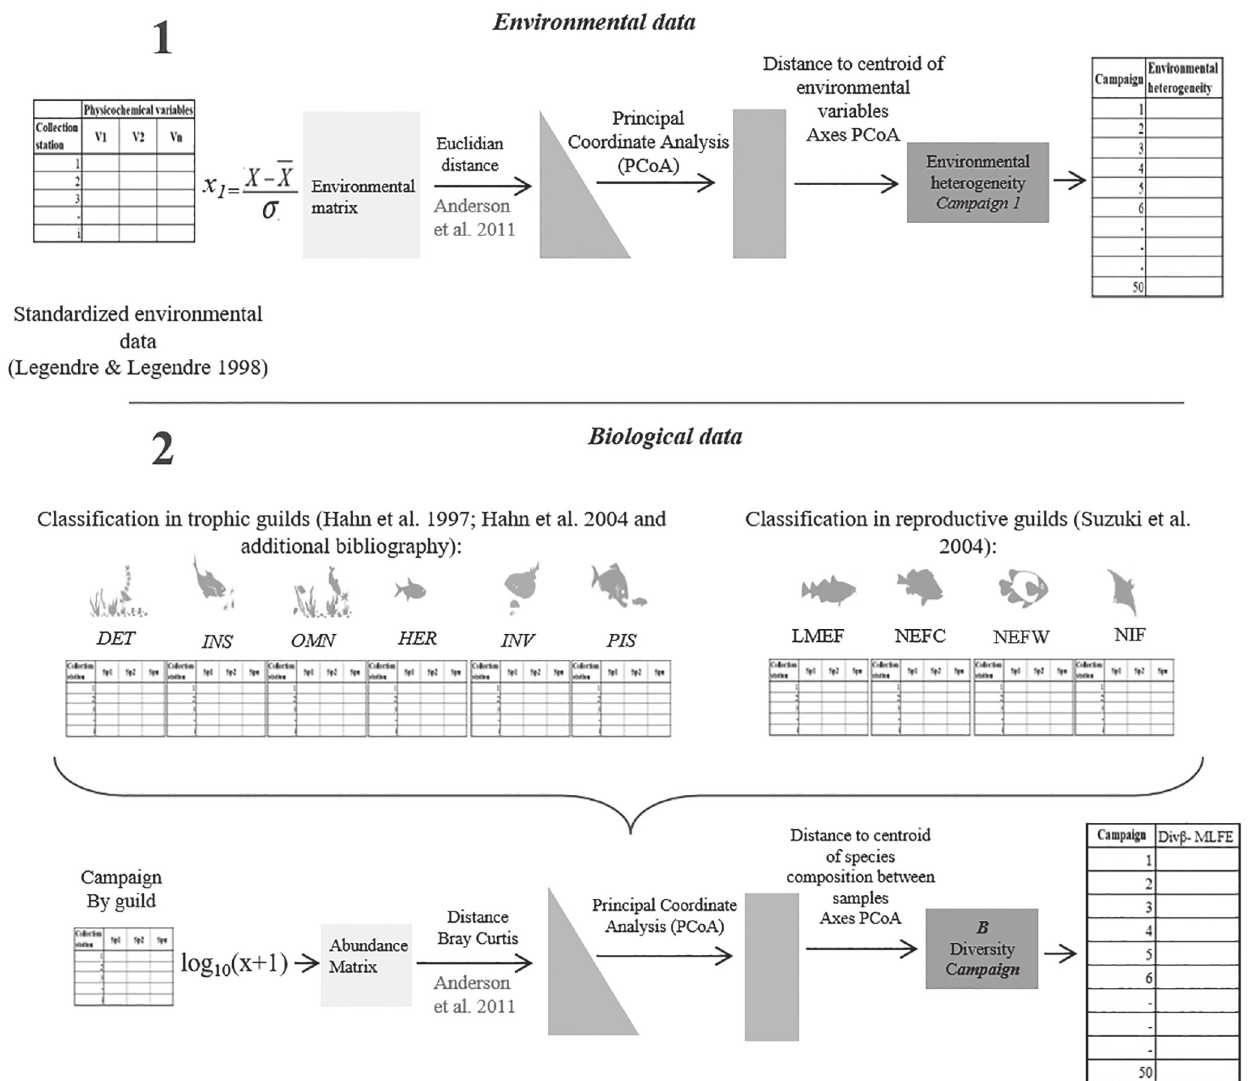
Fig. 3. Data analysis procedure for environmental heterogeneity and beta diversity for the different matrices of the trophic and reproductive